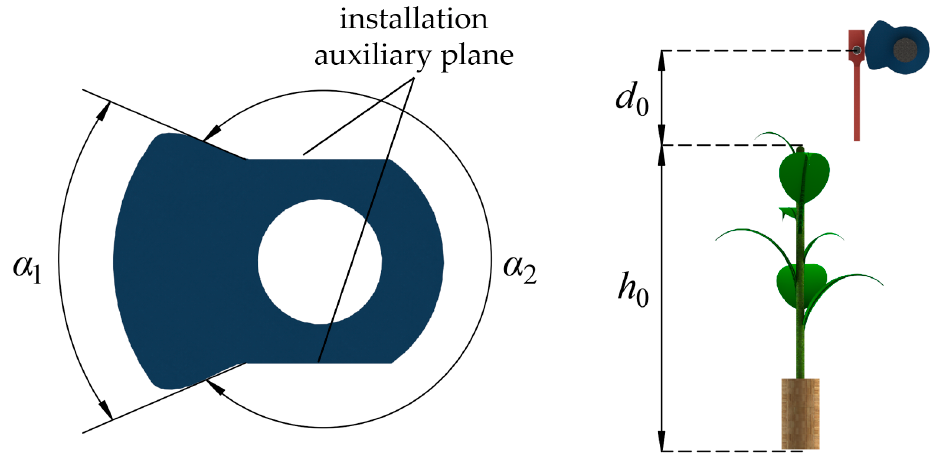
Figure 8. Drive cam and seedling dropping process.